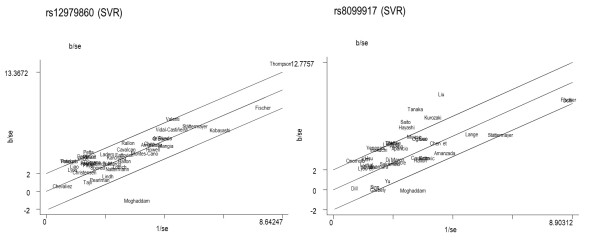
Galbraith plot. Detection of studies acting as possible sources of heterogeneity for rs12979860 and rs8099917 for sustained virologic response (SVR). Trials outside the Galbraith limits were trials where the 95% confidence interval did not contain the pooled estimate.